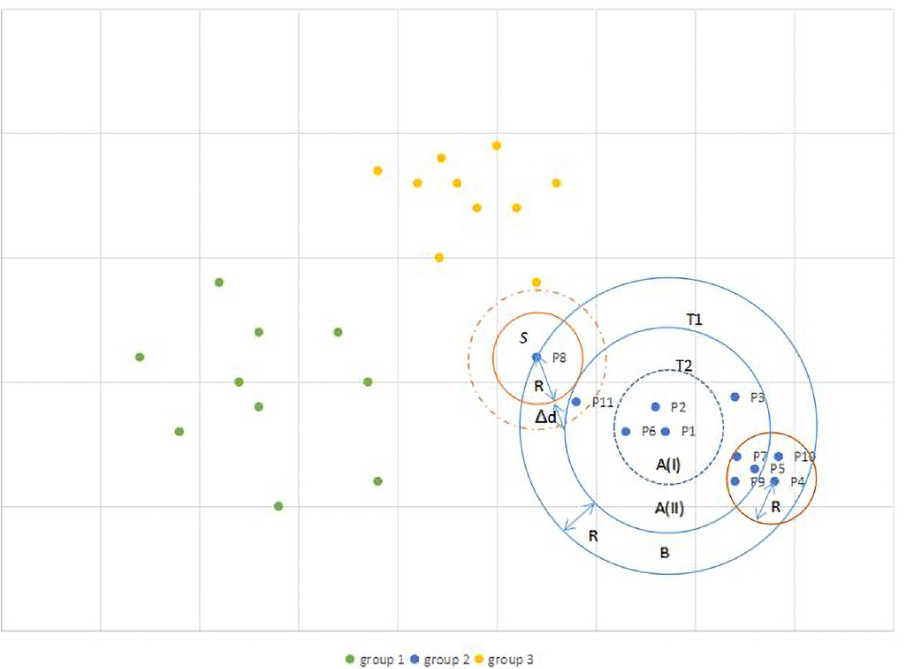
Fig 1. Application of TRCMGene to the toy